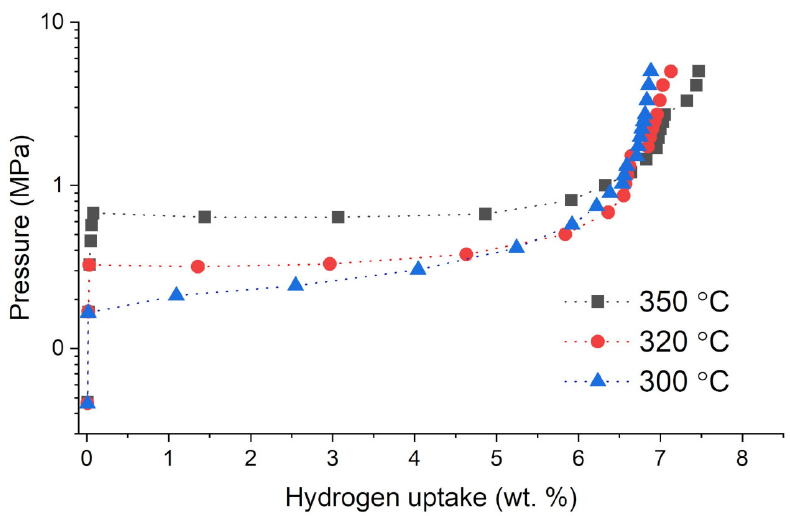
Figure 4. Hydrogen absorption isotherms for the Alloy 2 (10AgMg) sample as a representative for a group of alloys (5 wt. %, 10 wt. %, 15 wt. %, and 20 wt. % Ag).